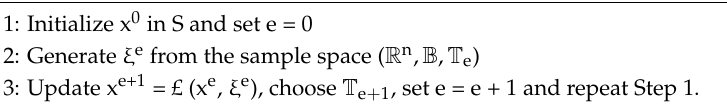
Algorithm 2. A conditioned approach to solving C